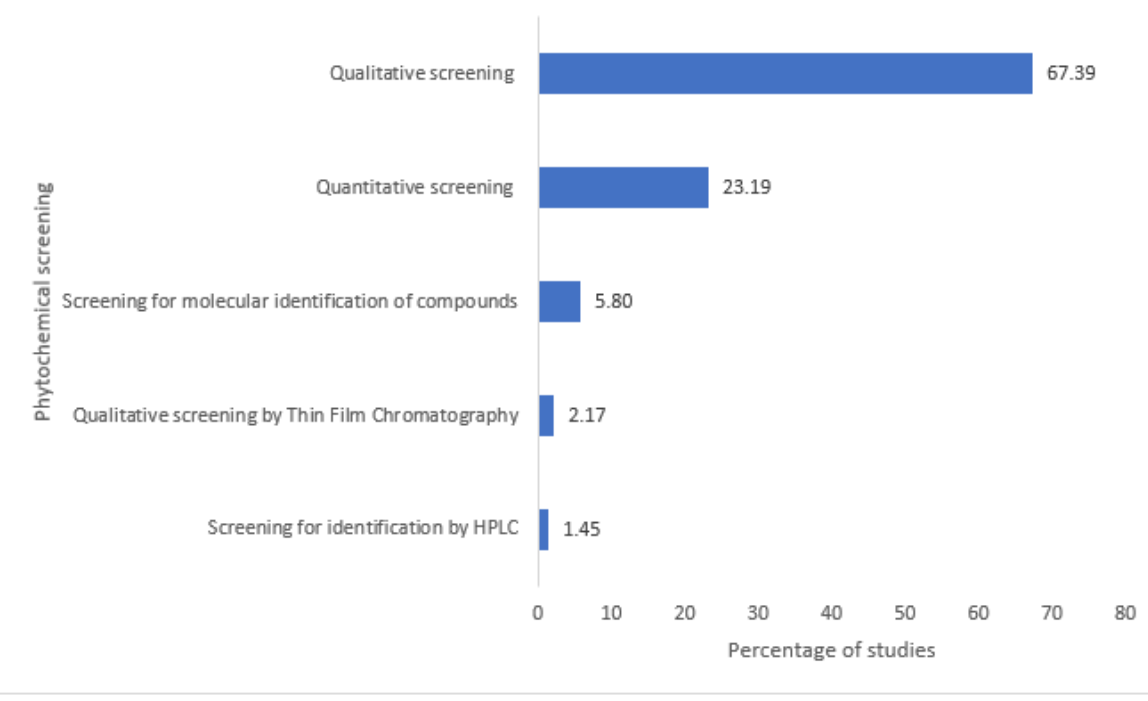
Figure 3. Summary of phytochemical studies of medicinal plants .